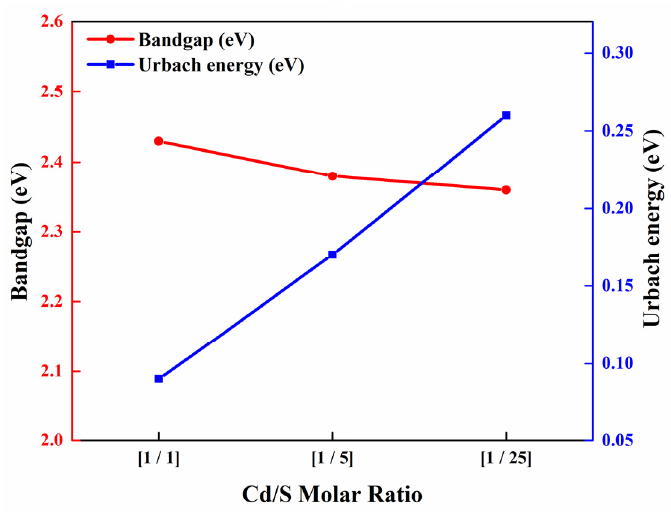
Figure 5. Urbach energy of Cd/S films.